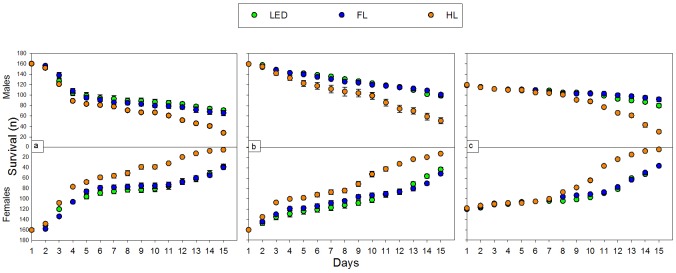
Male and female survival under three artificial light sources: 1) light-emitting diode (LED, green); 2) fluorescent lamp (FL, blue); and 3) halogen lamp (HL, amber) during the 15 days for Experiment 1 [a], Experiment 2 [b], and Experiment 3 [c].